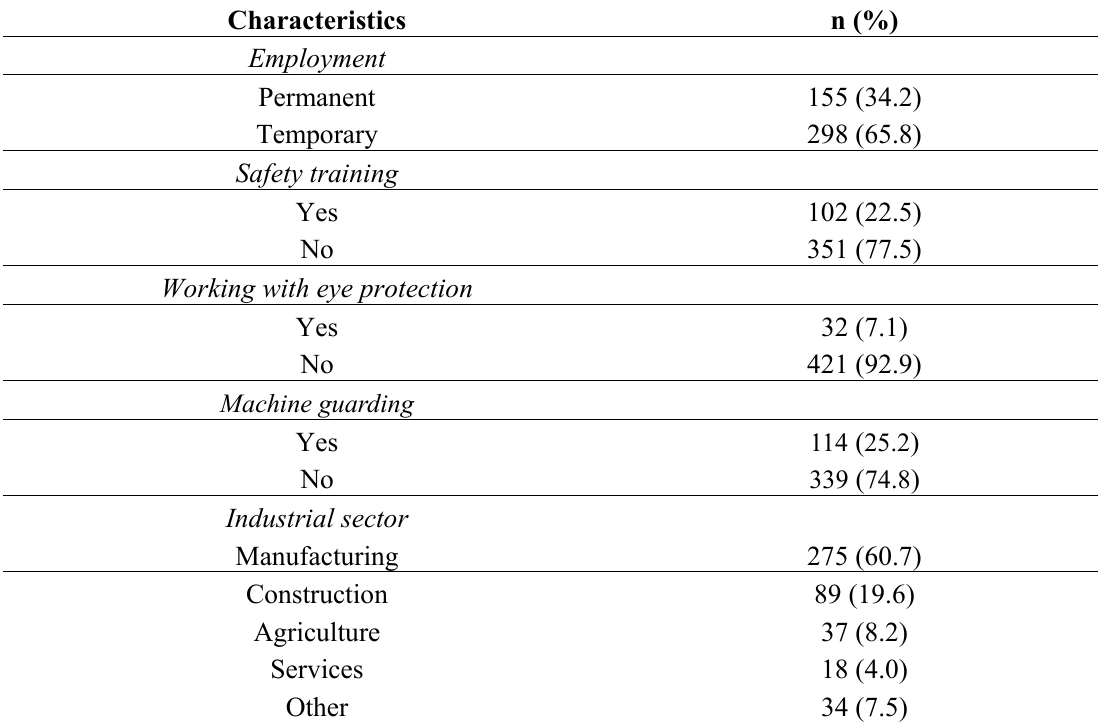
Table 2. Characteristics of occupational eye